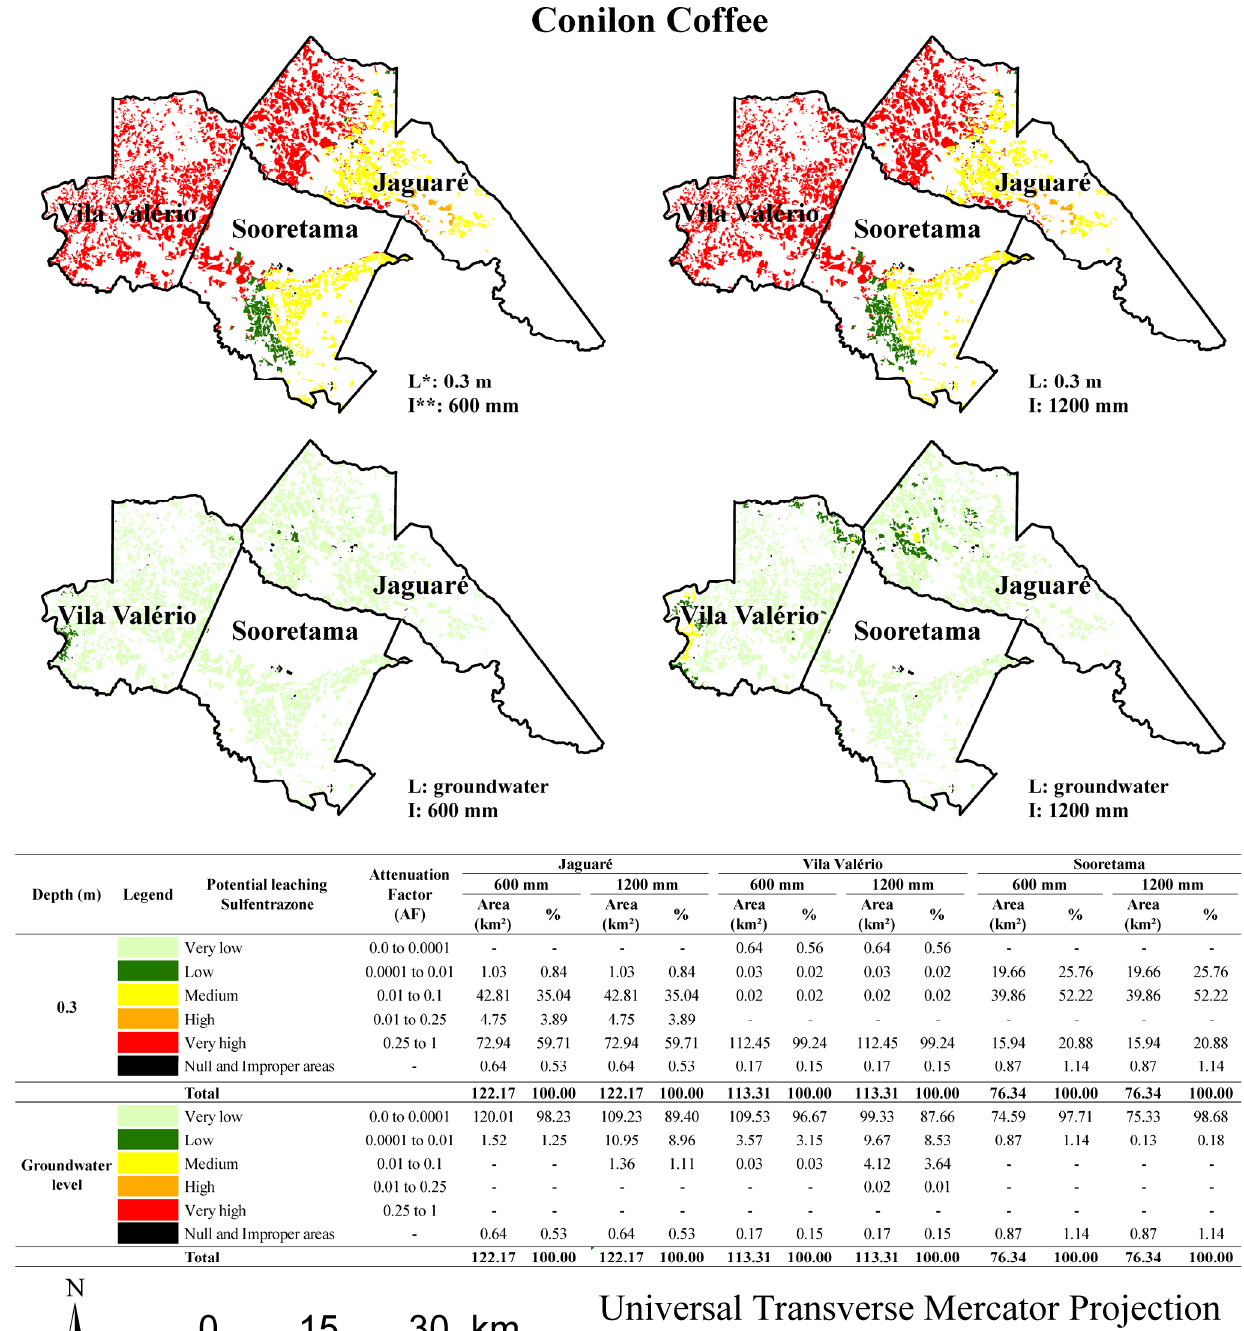
Figure 3. Attenuation Factor ( AF ) of active ingredient sulfentrazone evaluated for areas cultivated with conilon coffee ( Coffea canephora Pierre ex Froehner) for the municipalities of Jaguaré, Vila Valério and Sooretama, ES, Brazil. * L: Groundwater depth and ** I: Irrigation.